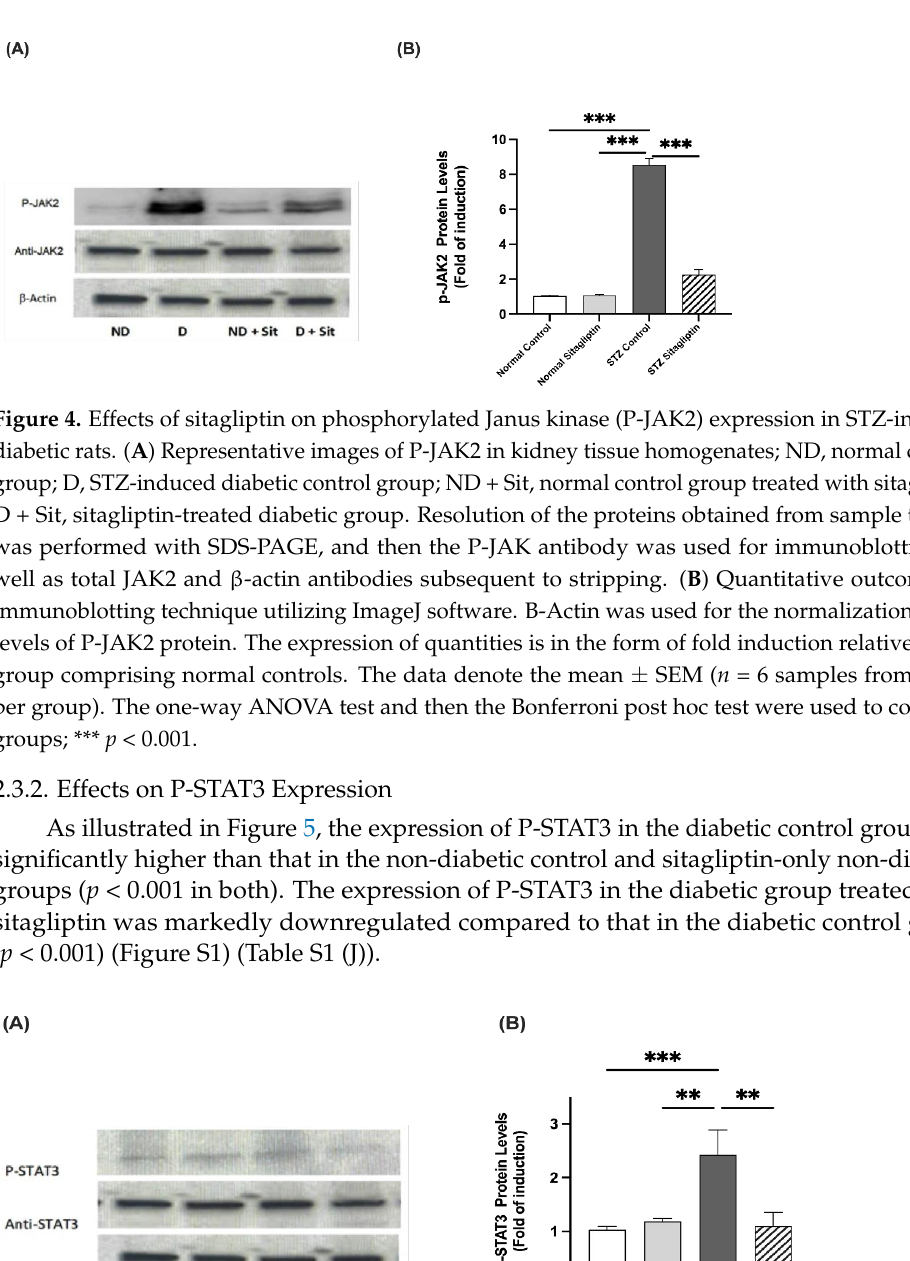
Figure 6. Effects of sitagliptin on protein tyrosine phosphatase 1B (PTP1B) expression in STZ-in- duced diabetic rats. ( A ) Images representing the immunoblotting of levels of proteins in the homog- enates of rat kidney tissues; ND, normal control group; D, STZ-induced diabetic control group; ND + Sit, normal control group treated with sitagliptin; D + Sit, sitagliptin-treated diabetic group. Reso- lution of the proteins obtained from the sample tissues was performed using SDS-PAGE, and then the PTP1B antibody was used for immunoblotting, along with the β-actin antibody subsequent to stripping. ( B ) ImageJ software was used to quantify the immunoblot band densities. β-Actin was utilized to normalize the levels of PTP1B protein. The expression of quantities is indicated as fold induction relative to the group comprising normal controls. Data denote the mean ± SEM ( n = 6 samples from six animals per group). The one-way ANOVA test and then the Bonferroni post hoc test were used to compare groups; *** p < 0.001.